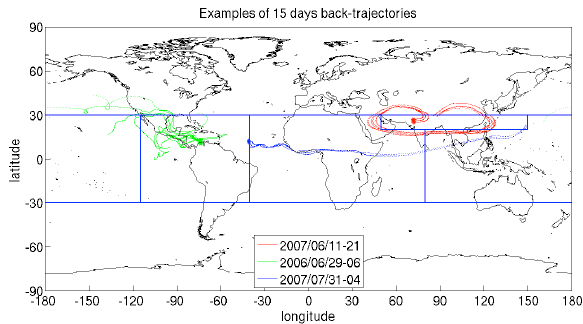
Fig. 4. Examples of three 15-days back-trajectories. For each, dots identify the position of the SVC used to initiate back-trajectory